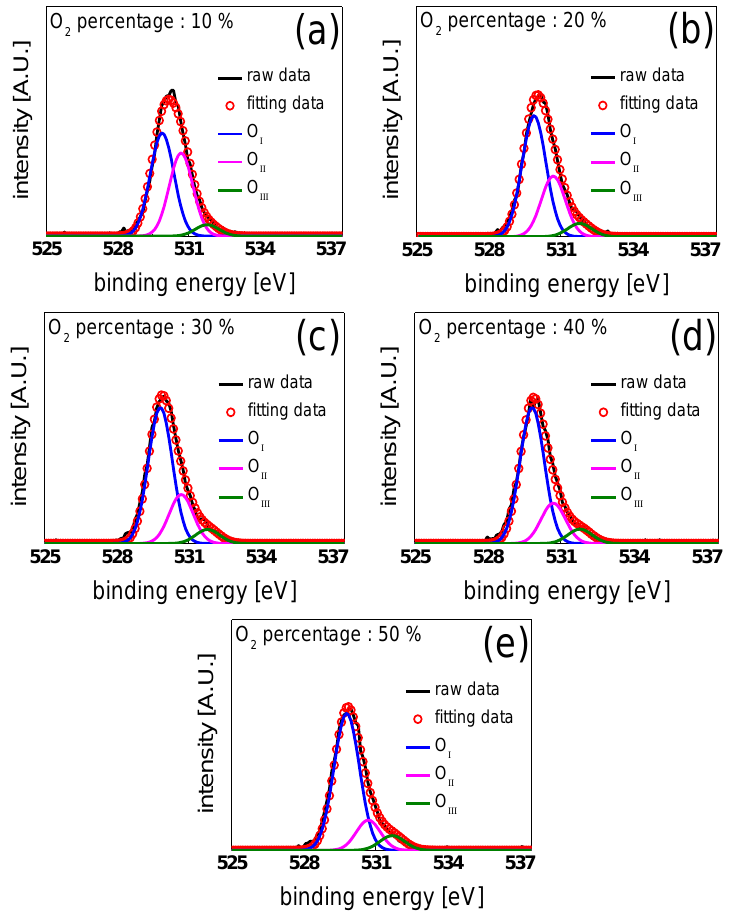
Figure 7. O 1s core-level XPS results of the IGTO thin films prepared at the oxygen contents of ( a ) 10%, ( b ) 20%, ( c ) 30%, ( d ) 40%, and ( e ) 50%.